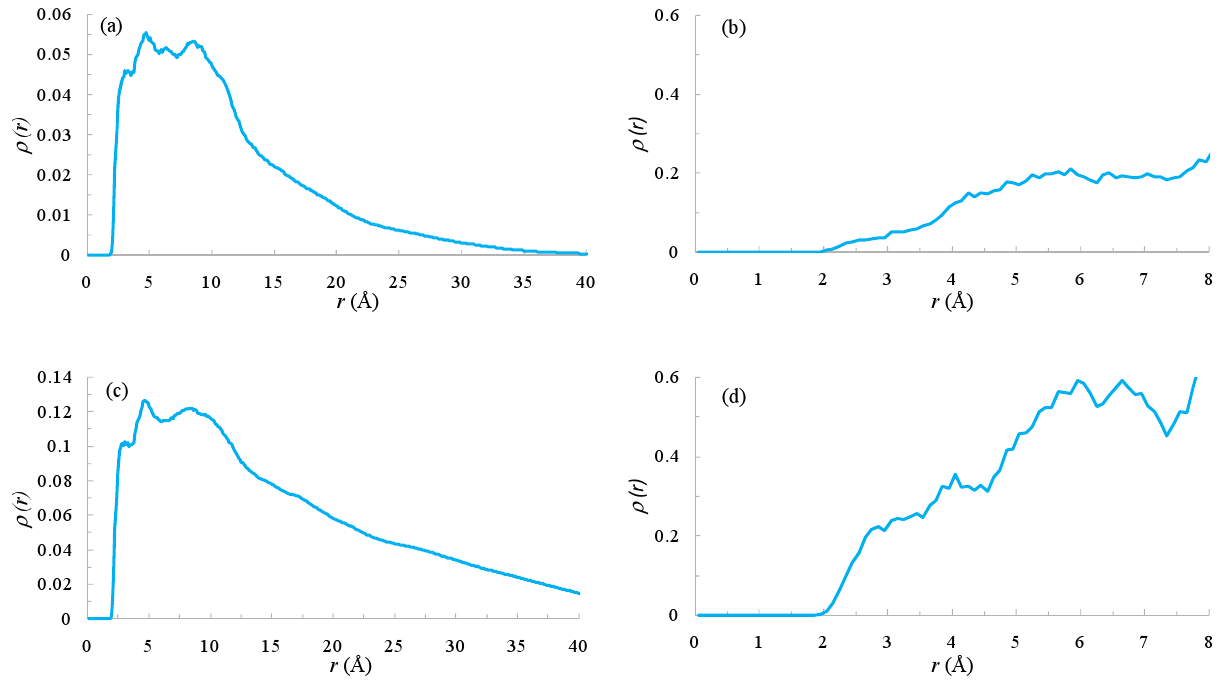
BPO ; ( b ) Intramolecular density 2 16 BPO ; ( d ) Intramolecular density distribution 4 64 BPO . 4 64